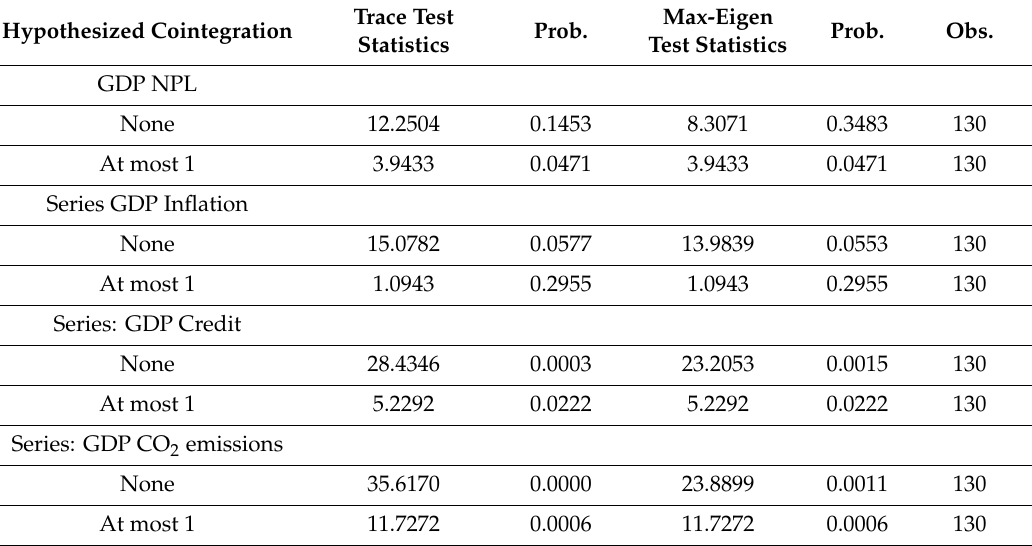
Table 11. Individual cross-section results—Romania.